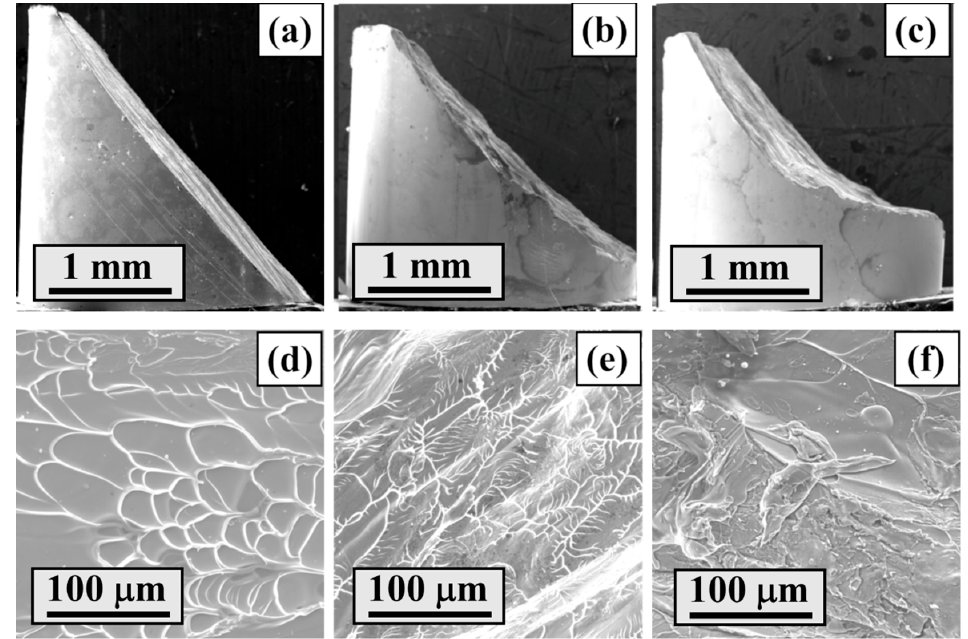
Figure 6. Side view and fracture surface details of ZC3 under different strain rates ( a , d ) 10 − 5 s − 1 , ( b , e ) 100 s − 1 , and ( c , f ) 2500 s − 1 .